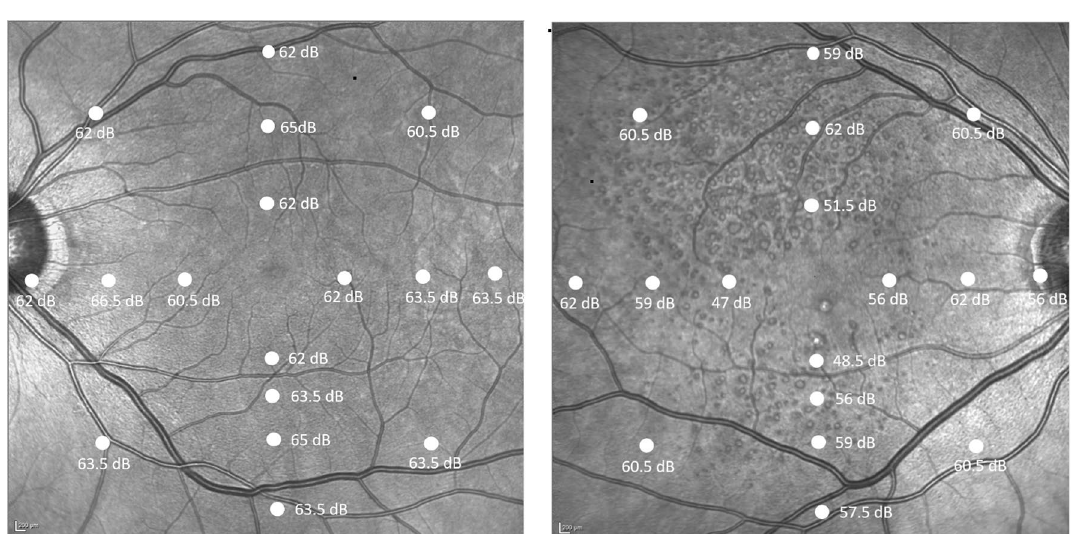
Figure 6. Example of pointwise sensitivities in a patient with healthy retina ( A ) and iAMD with SDD ( B ) with the scotopic thresholds topographically displayed over the infrared image across all 17 loci shown (4, 8, 12 and one additional location at 6° eccentricities nasal, temporal, superior and inferior to the fovea). The sensitivities were decreased in the paracentral loci compared to peripheral loci in ( B ) compared to ( A ). Images generated from Heidelberg Eye Explorer version